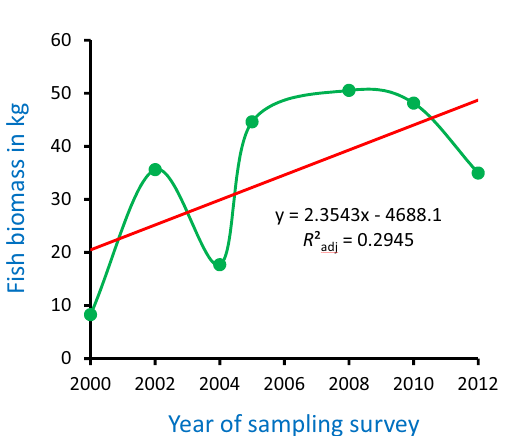
Table 3. Fish biomass in the recovered course of the Ner River, Poland, at the beginning and end of the fish sampling period (percentages were obtained from untransformed biomass values, see Table S1).